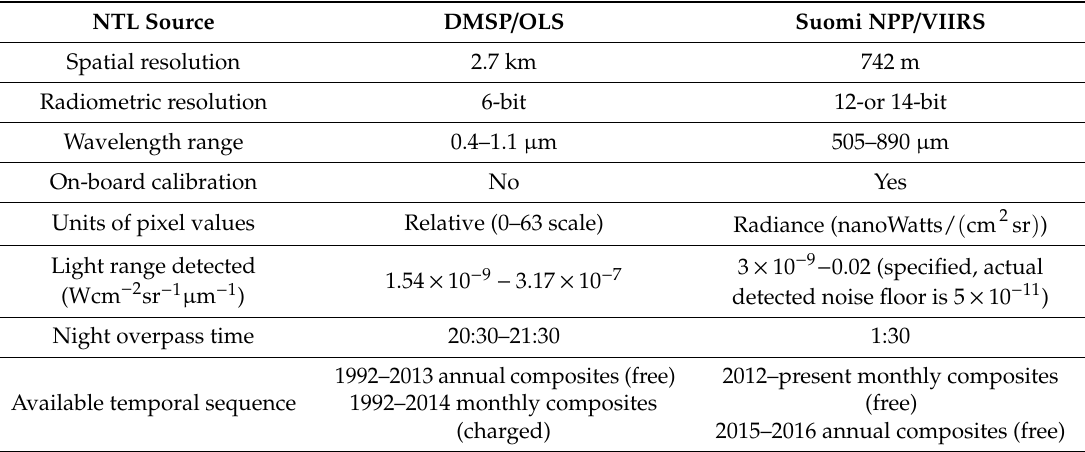
Table 1. Comparisons between the Defense Meteorological Satellite Program (DMSP) and Visible Infrared Imaging Radiometer Suite (VIIRS) nighttime light images